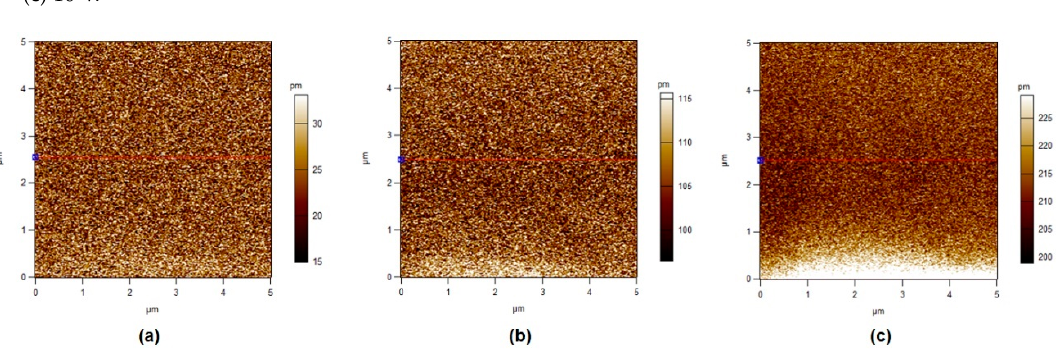
Figure 10. PFM Amplitude retrace of PVDF / TPU (1:1) at di ff erent applied voltages. ( a ) 1 V, ( b ) 5 V, and ( c ) 10